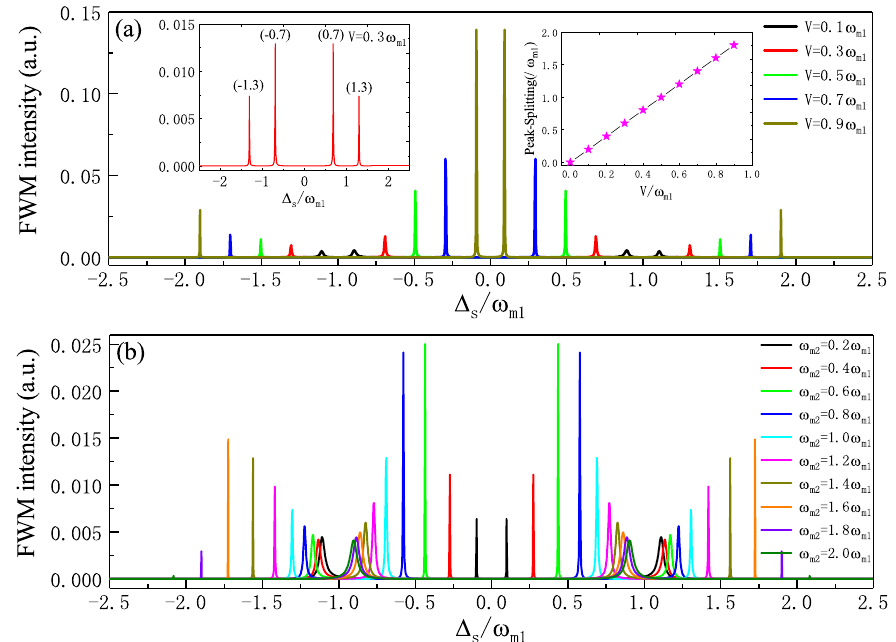
Figure 3. ( a ) The FWM spectra for five different coupling strengths V at P c = 5 µ W and ω m 1 = ω m 2 in the case of ∆ c = ω m 1 , and the left inset is V = 0.3 ω m 1 , the right inset plots the splitting of the two sideband peaks as a function of the coupling strength V . ( b ) The FWM spectra as a function of ∆ s for several different resonator frequencies with the parameters P c = 5 µ W and V = 0.3 ω m 1 in the case of ∆ c = ω m 1